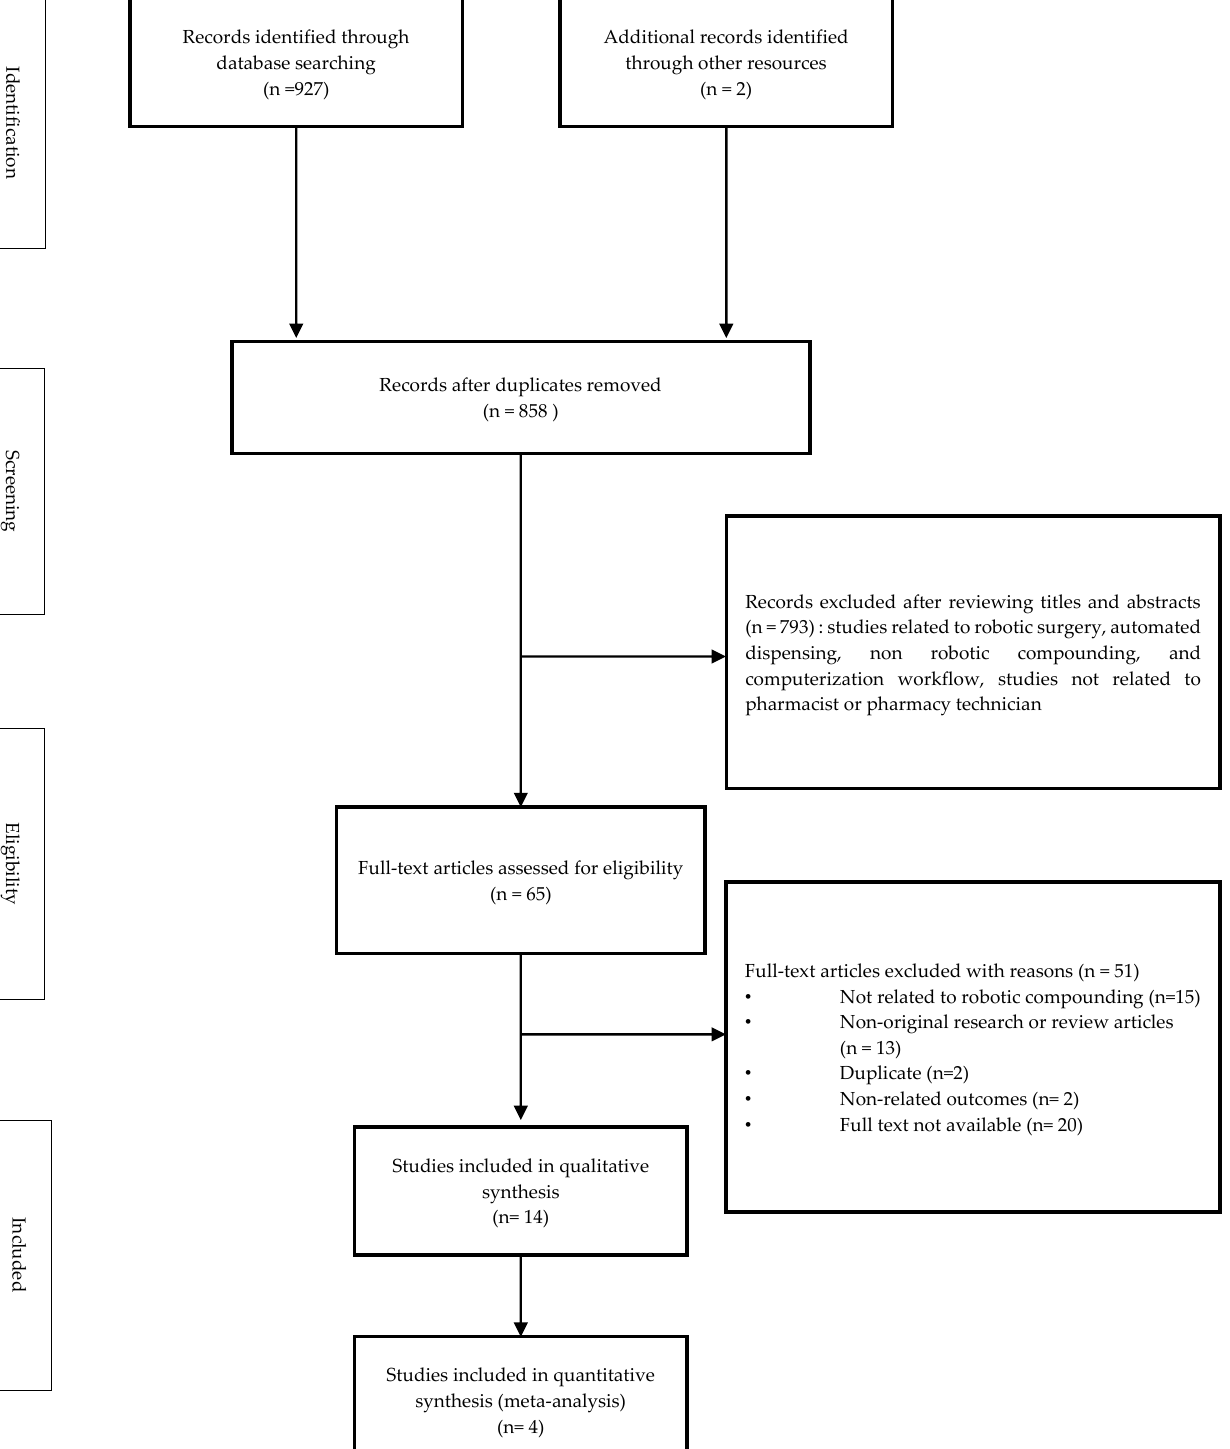
Figure 1. Flow chart showing study identification and selection. Outcomes related to the performance of the compounding robot were measured in terms of accuracy, drug preparation time, and safety, including drug contamination of infusion bags or gloves worn by the robot operator. Of the outcomes, only contam- ination after compounding and contamination of infusion bags were appropriate for quantitative